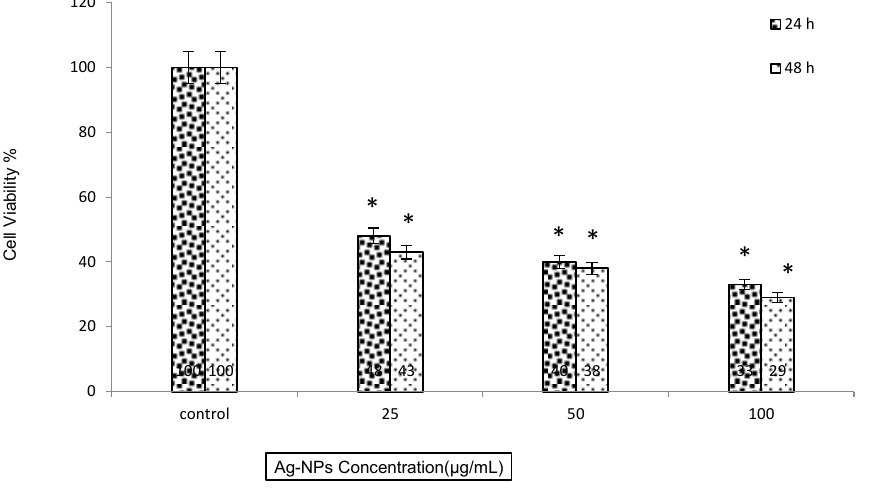
Figure 6. MTT assay results from treatment MCF-7 cell with various Ag-NPs concentration in 24 h and 48 h, Mean ± SD, * p ˂